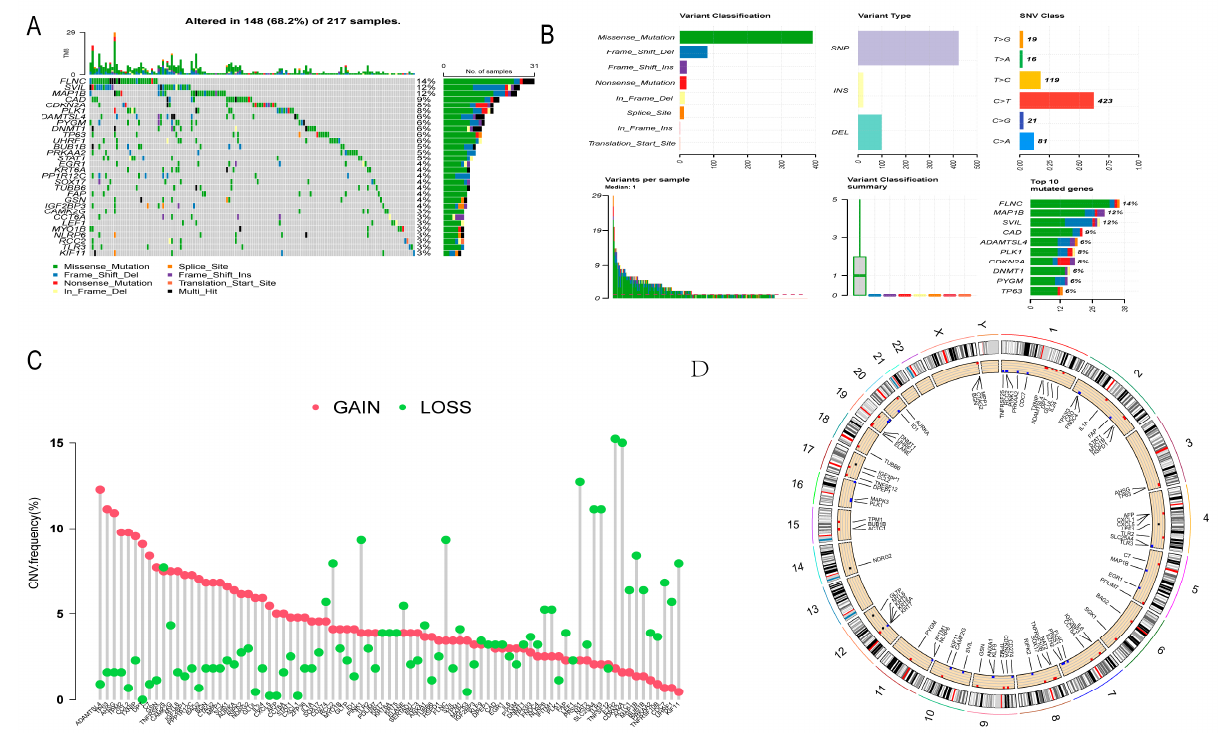
Figure 3. Mutation and CNV analysis of NRGs in GC. ( A , B ) The mutation frequency and classification of diff-NRGs in GC. ( C ) Copy number deletion and amplification of diff-NRGs (red for GAIN, green for LOSS). ( D ) CNV changes of diff-NRGs on